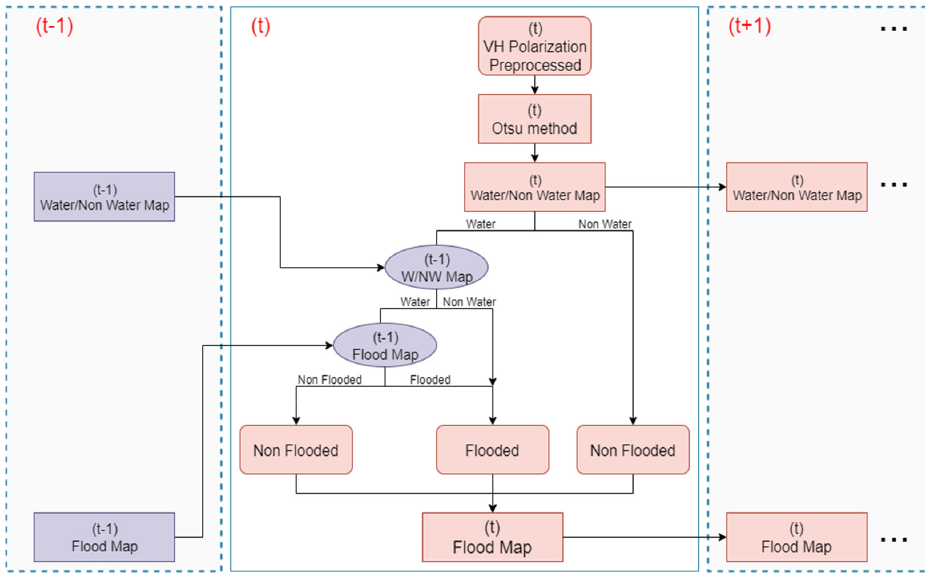
Figure 7. Flood monitoring algorithm using change-detection-based time series analyses on the Sentinel-1 SAR images.